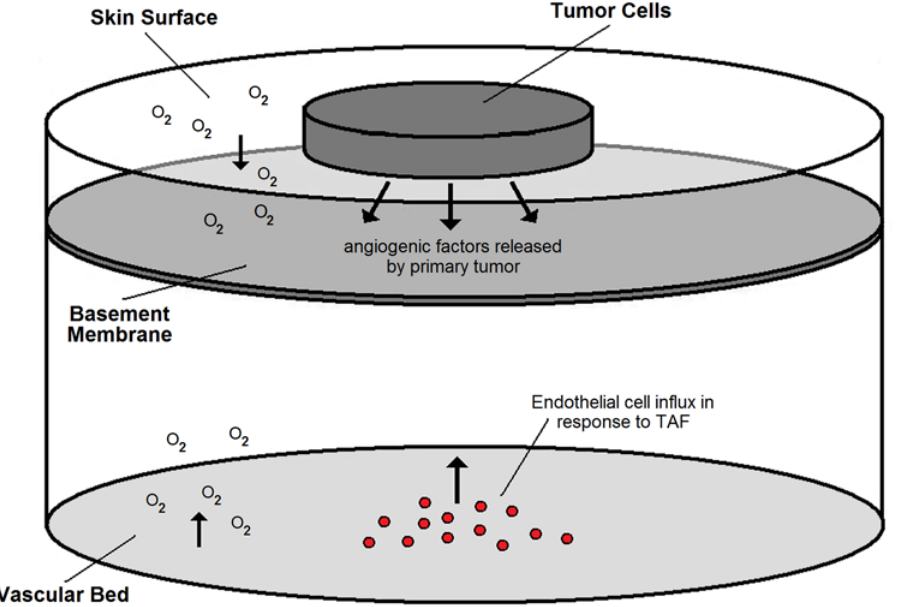
Figure 1. A simple schematic of the modeled geometry. The epidermis is separated from the dermis by a sheet of basement membrane. At the base of the dermis is a vascular bed from which all endothelial cells migrate. Oxygen diffuses into the domain from the vascular bed and at the skin surface. The melanoma tumor originates in the epidermis. All other tissue is initially healthy cells.